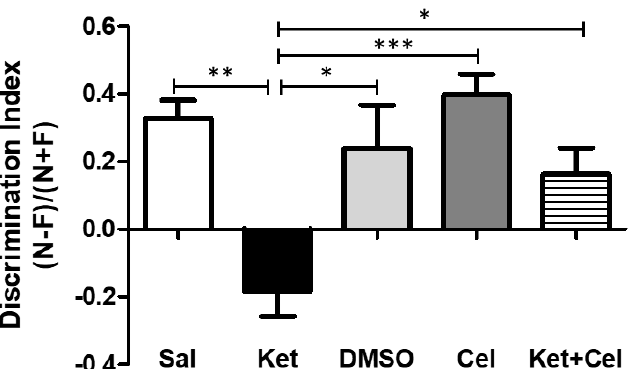
Figure 1. Celastrol administration in postnatal life prevented ketamine-induced cognitive dysfunctions, evaluated at adulthood. Discrimination index (N − F) / (N + F) ( N = time spent in exploration of the novel object during the T2; F = time spent in exploration of the familiar object in the T2) in adult mice receiving saline (Sal, n = 6) or ketamine (Ket, n = 13) or a 50% DMSO in phosphate-bu ff ered saline (PBS) (DMSO, n = 7) or celastrol (Cel, n = 6) or ketamine + celastrol (Ket + Cel, n = 14) at PNDs 7, 9